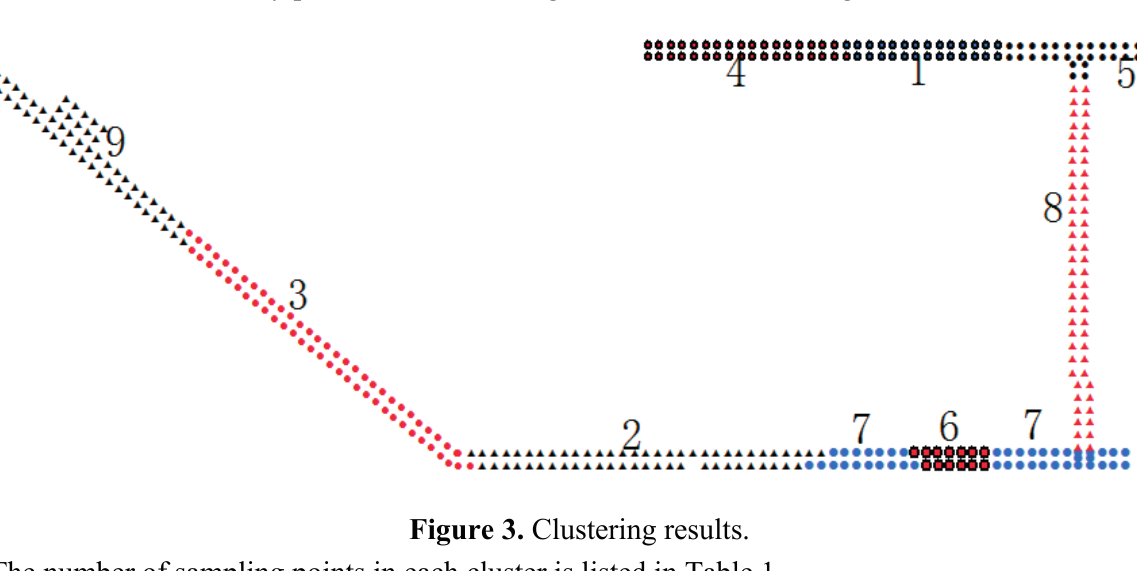
Figure 3. Clustering results.